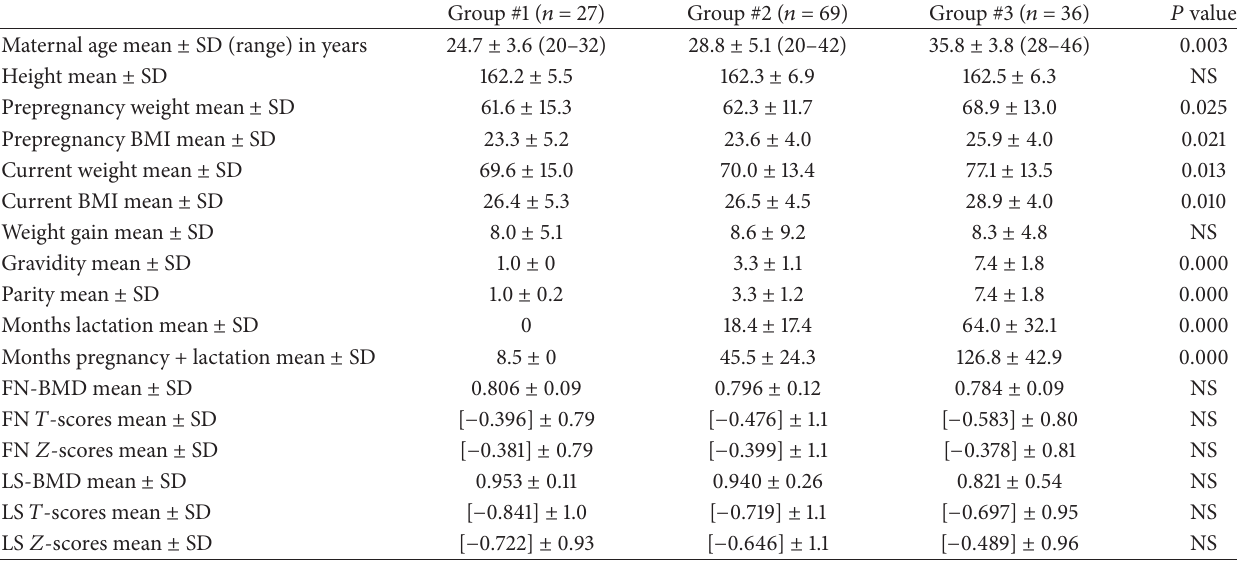
Table 4: Comparison variables among groups subdivided by parity (Group #1: primiparous; Group #2: 2–5 births; Group #3: ≥ 6 births); significance based on Levene’s test for Equality of Variances.